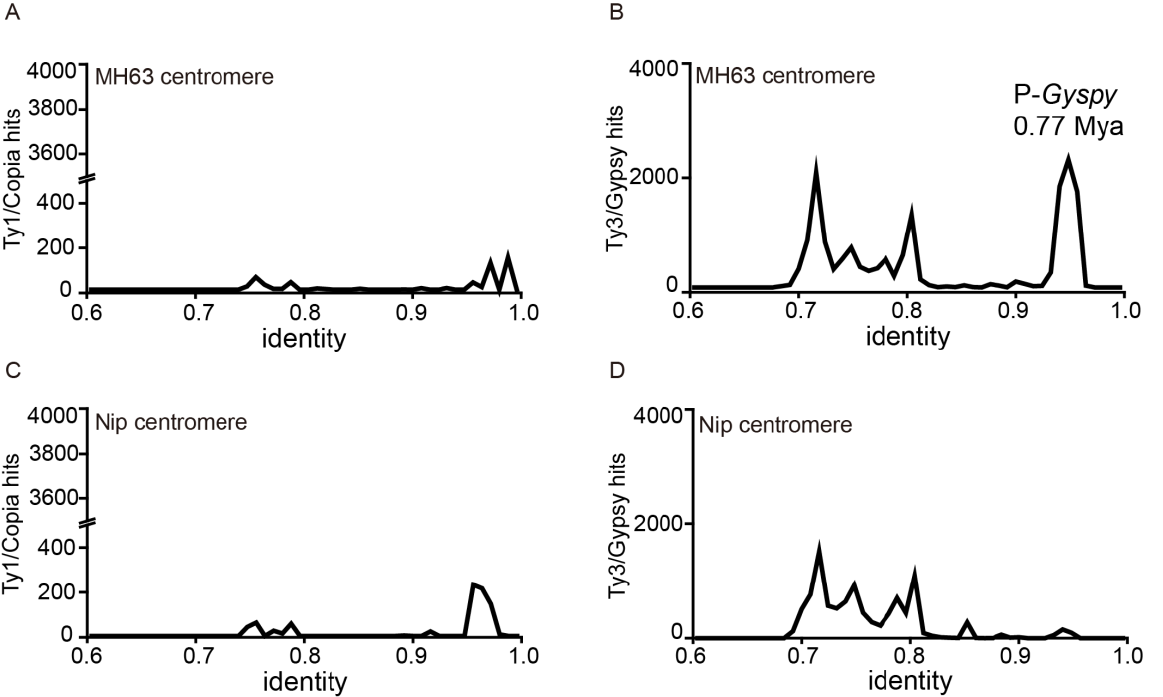
Figure 5. The centromeres of MH63 and Nip were scanned with Ty1 / Copia and Ty3 / Gypsy ORF reference sequences and normalized with sequence identities. ( A ) MH63 centromere scanning and normalizing with ref-M-Ty1 / Copia . ( B – D ) In the same way. Individual peak P- Gypsy ( p value = 0.03) was observed in the MH63 centromeres, and the age of the peaks was 0.77